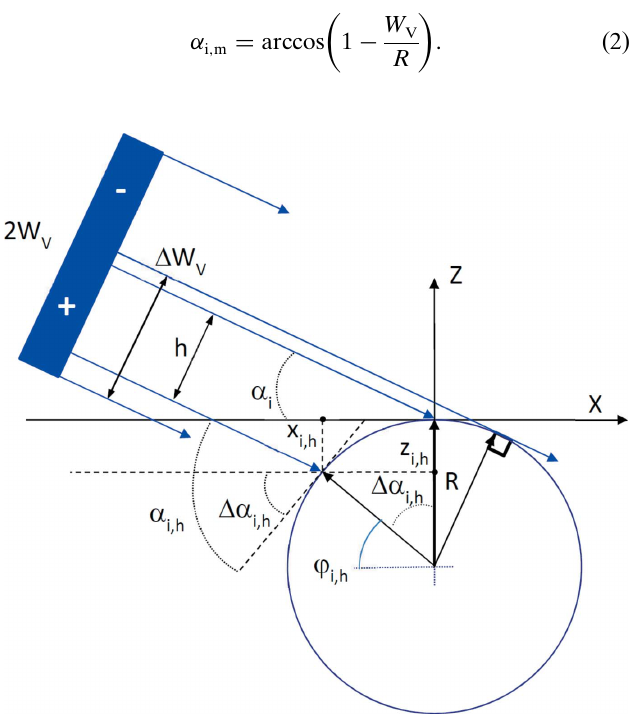
Figure 3 Detailed scheme of the incidence beam with a vertical size 2 W V as defined by slits before the sample as it impinges on the curved surface with the definition of angles used in formulas. The incident beam comes from the left. Narrow blue lines represent elementary rays. Here, h is the offset of the elementary ray from the beam center. This ray impinges with the circular surface of radius R at the point with coordinates ( x i, h , z i, h ). The angle a i is the effective grazing angle, while a i, h and (cid:2) a i, h are the actual grazing angle at the point ( x i, h , z i, h ) and the difference of this angle from a i ,